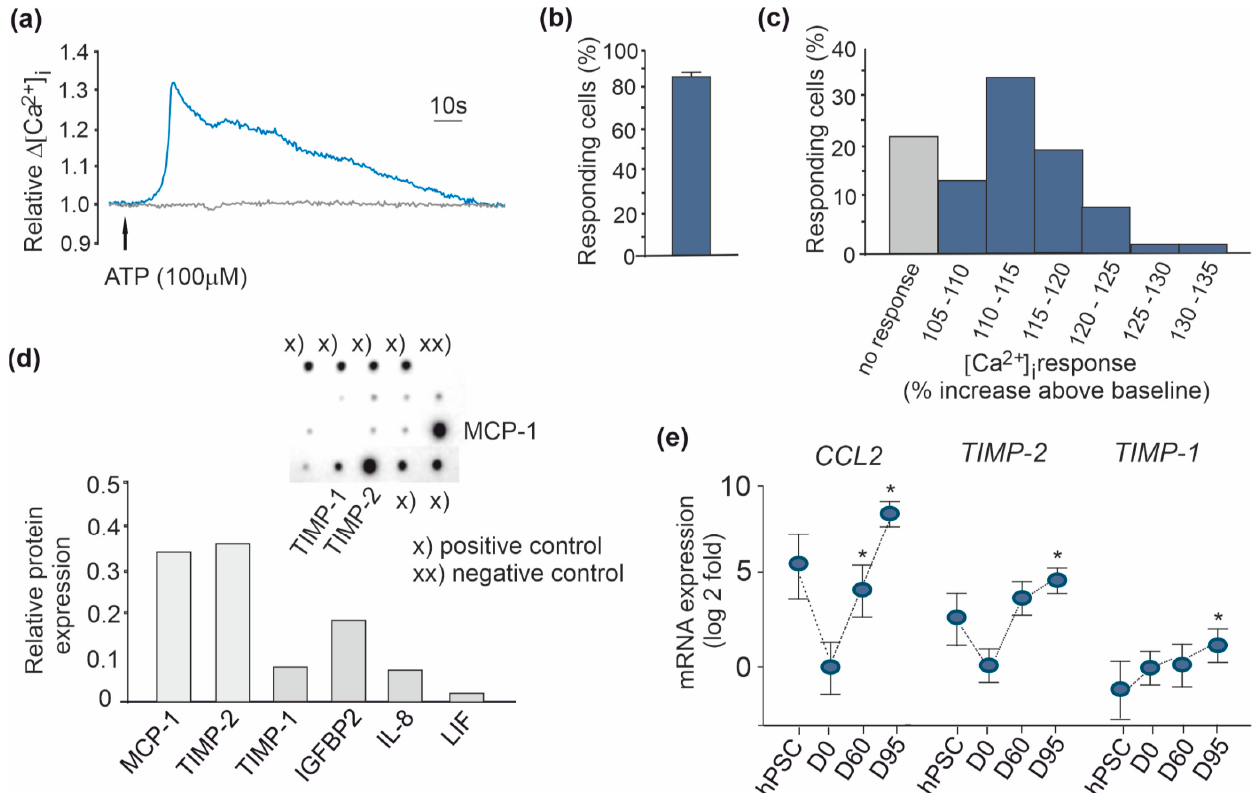
Figure 5. Functional testing of D95 astrocytes. ( a ) Representative single cell response to ATP in intracellular calcium recordings of astrocytes, ( b ) the number of cells responding to ATP (data are expressed as mean ± SEM), and ( c ) the distribution of cell responses suggesting high purity of the astrocyte population. n = 5 cell lines used in repeated studies, responses of 75–100 cells were measured in each experiment. ( d ) Monocyte chemoattractant protein-1 (MCP-1), tissue inhibitor of metalloproteinases-2 (TIMP-2), tissue inhibitor of metalloproteinases-1 (TIMP-1), Insulin Growth-Factor-Binding Protein 2 (IGFBP2), interleukin-8 (IL-8), and Leucemia Inhibitory Factor (LIF) amounts in astrocyte-conditioned medium (ACM). ( e ) Expression of CCL2/MCP-1 , TIMP-2 , and TIMP-1 relative to neurosphere expression (D0) in RNA-seq data of aged D60 and D95 cells and undifferentiated hPSCs. * p < 0.05, p adjust < 0.1.